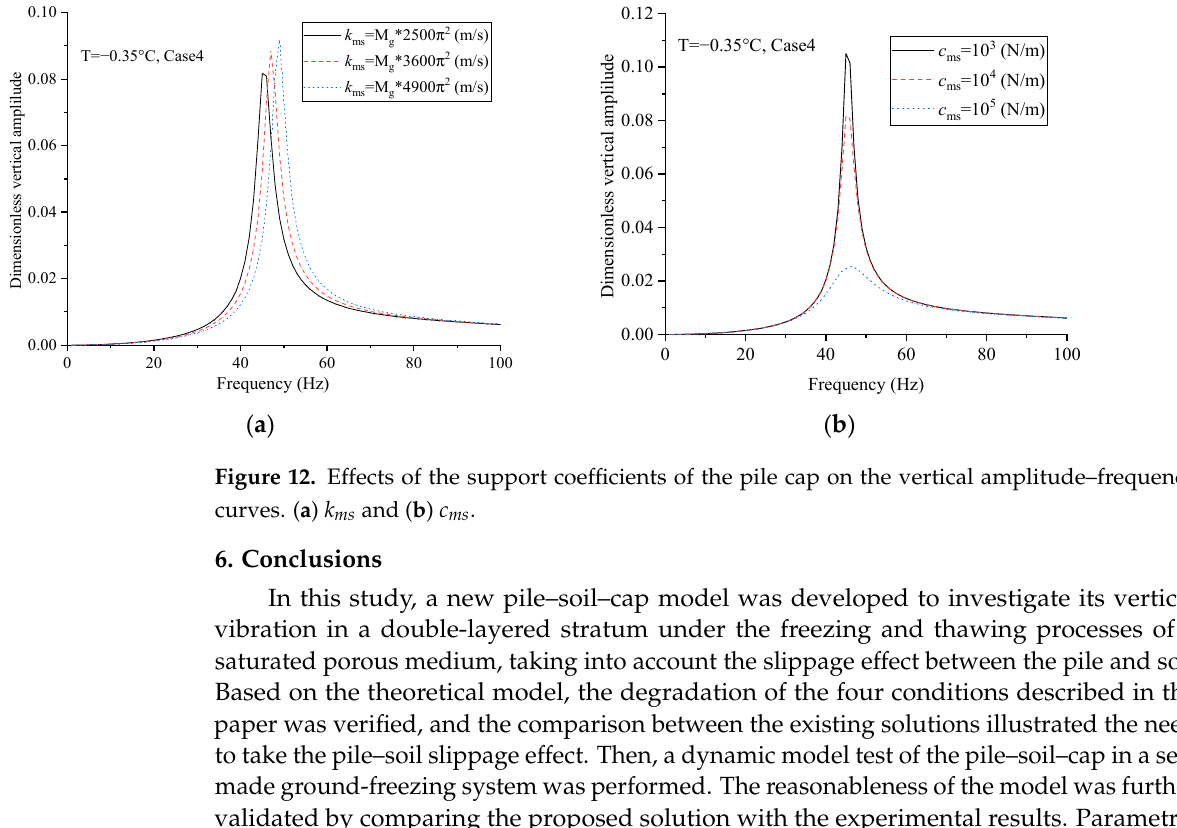
( b ) Figure 11. Influence of the pile cap mass on the amplitude–frequency curves of the single-pile foun- dation. ( a ) Case 2 and ( b ) Case 4. 5.2.4. Influence of the Support Parameters at the Pile Cap Bottom